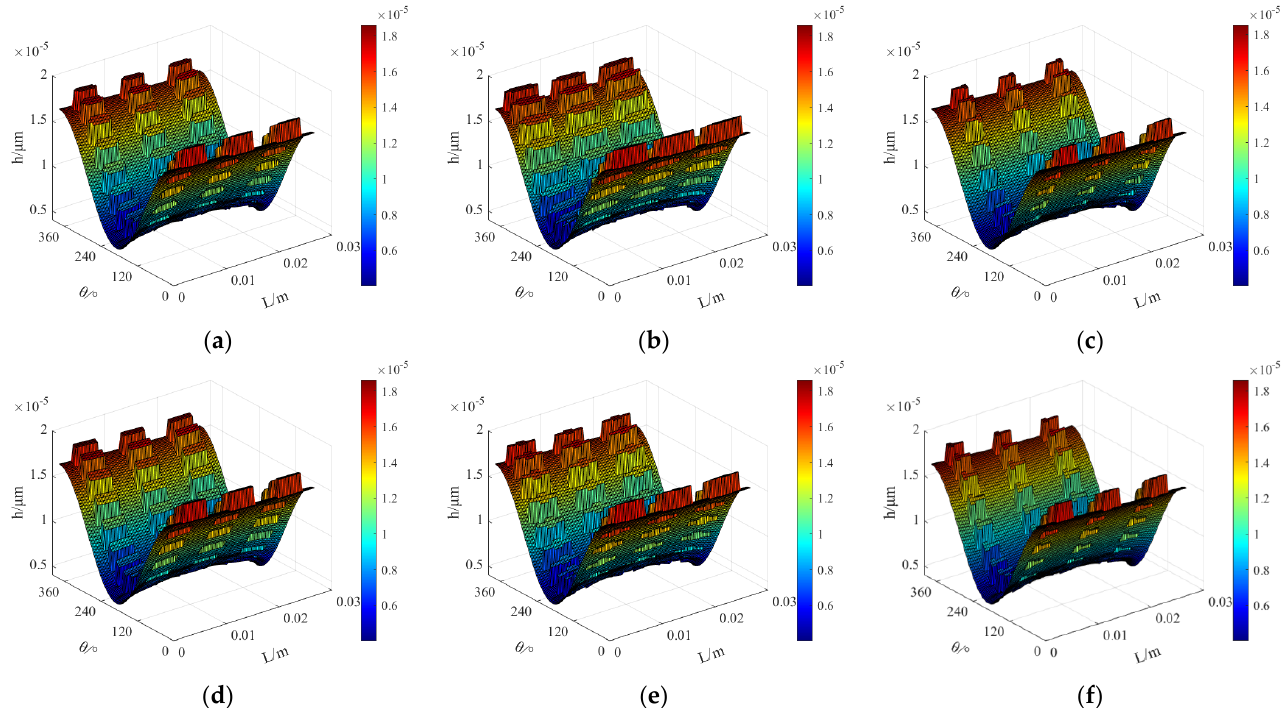
Figure 6. The thickness of the gas film with ( a ) circular texture ( b ) elliptical texture ( c ) triangular texture ( d ) square texture ( e ) diamond-shaped texture and ( f ) inverted triangular texture.